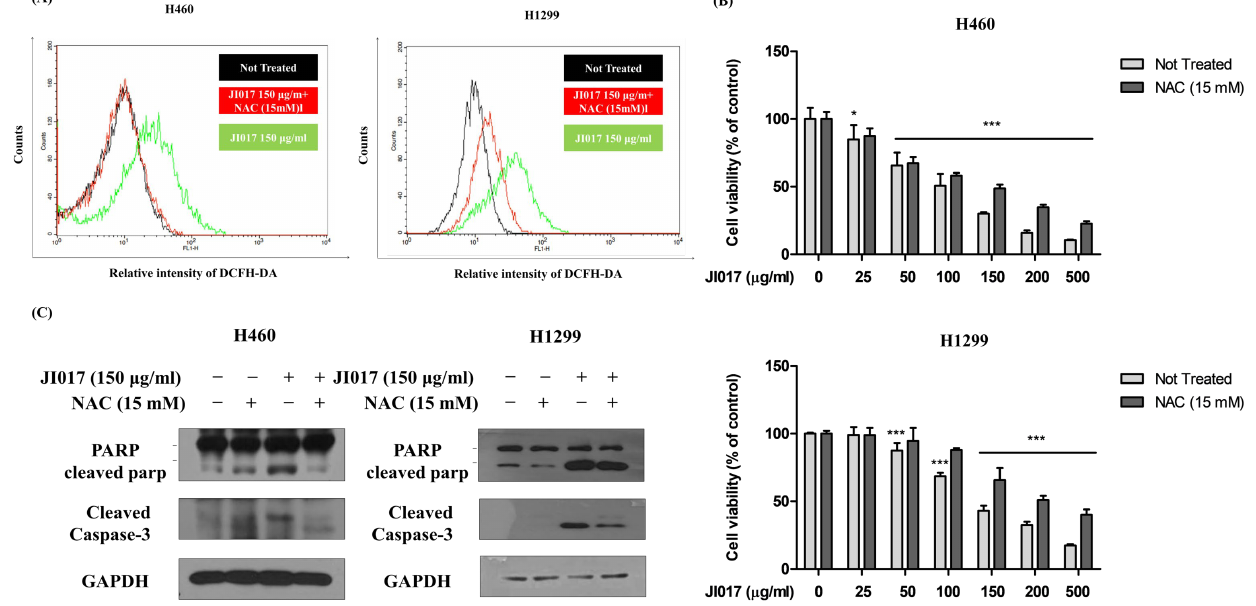
Figure 2. Effect of JI017 in A549, H460, and H1299 ROS accumulation. ( A ) Treatment with JI017 (150 µg/mL) in H460 and H1299 cells for 24 h; they were labeled with DCFH - DA (10 µM) for 30 min . Additionally, intracellular ROS levels were determined by flow cytometry. Pretreatment with NAC (15 mM) for 1 h was followed by treatment with various concentrations of JI017. ( B ) Cell viability was measured using the MTS assay. ( C ) Whole cell lysates were analyzed by Western blotting with anti - PARP, anti - cleaved caspase 3, and anti - GAPDH antibodies. Data are presented as the mean ± SEM. * p < 0.05 and *** p < 0.001 compared to untreated cells.